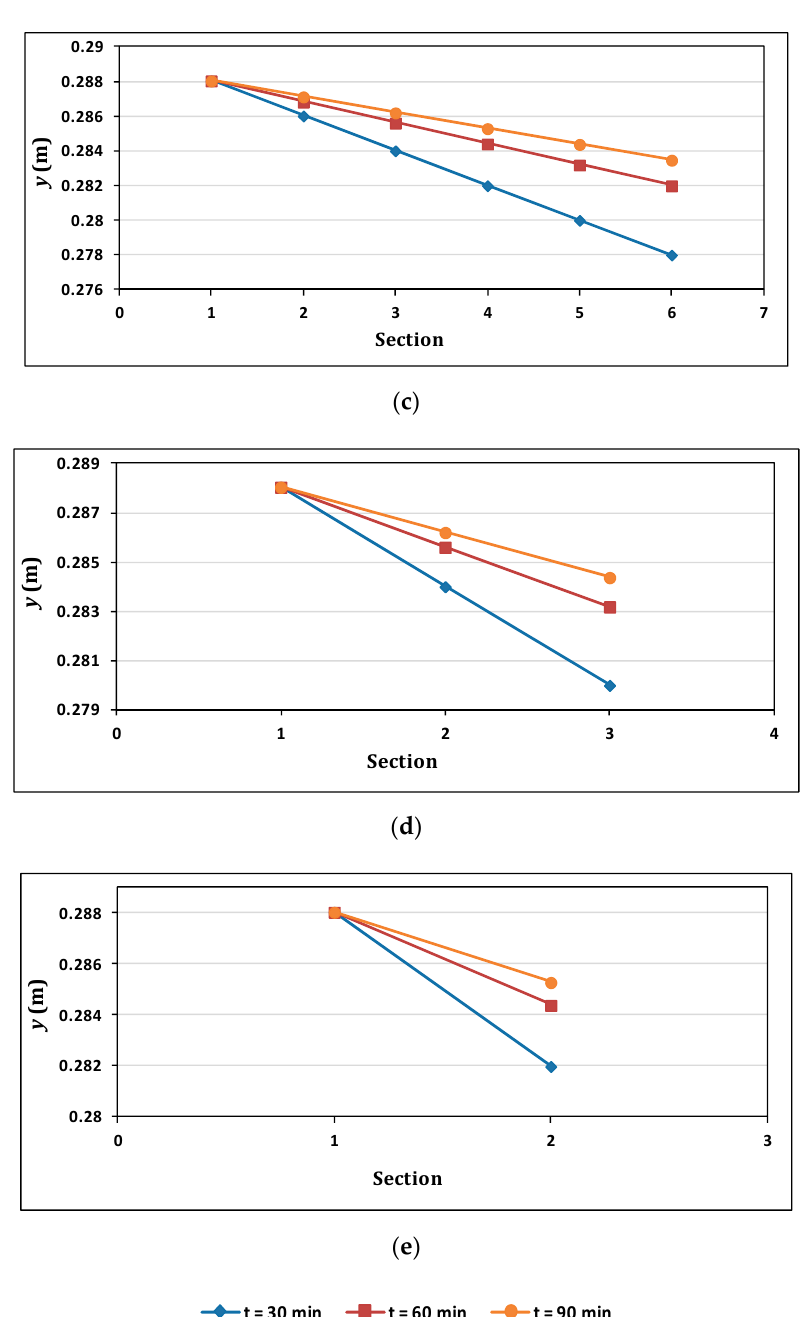
Figure 10. Water level along the channel sections for different times for different check dam design cases: ( a ) case 1; ( b ) case 2; ( c ) case 3; ( d ) case 4; ( e ) case 5.